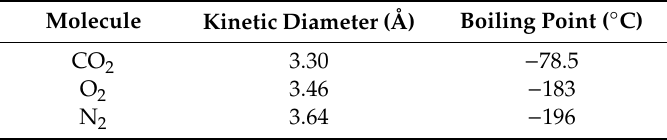
Table 4. N 2 , O 2 , and CO 2 kinetic diameters and boiling points [40].